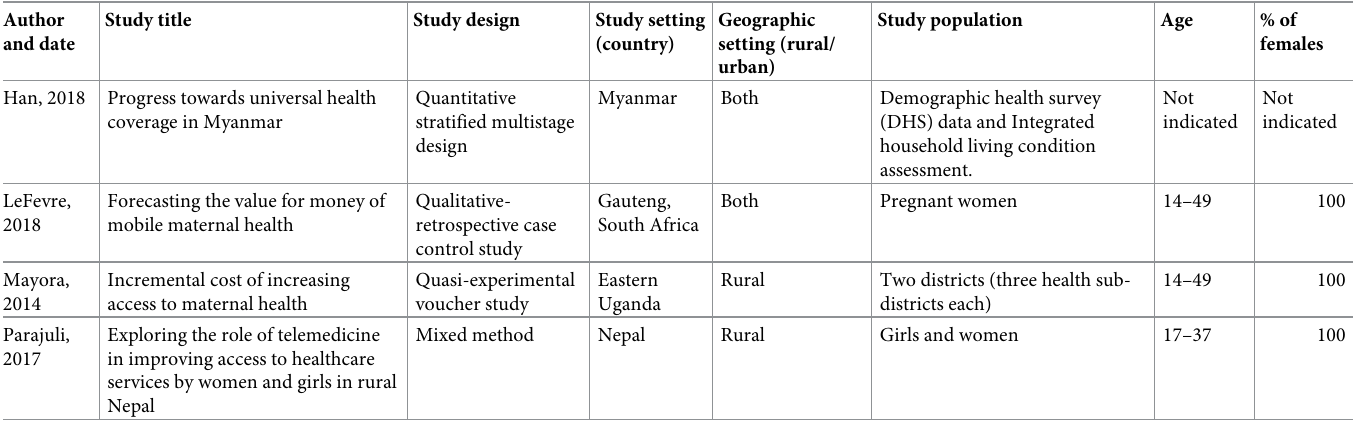
Table 4. Results for individual sources of